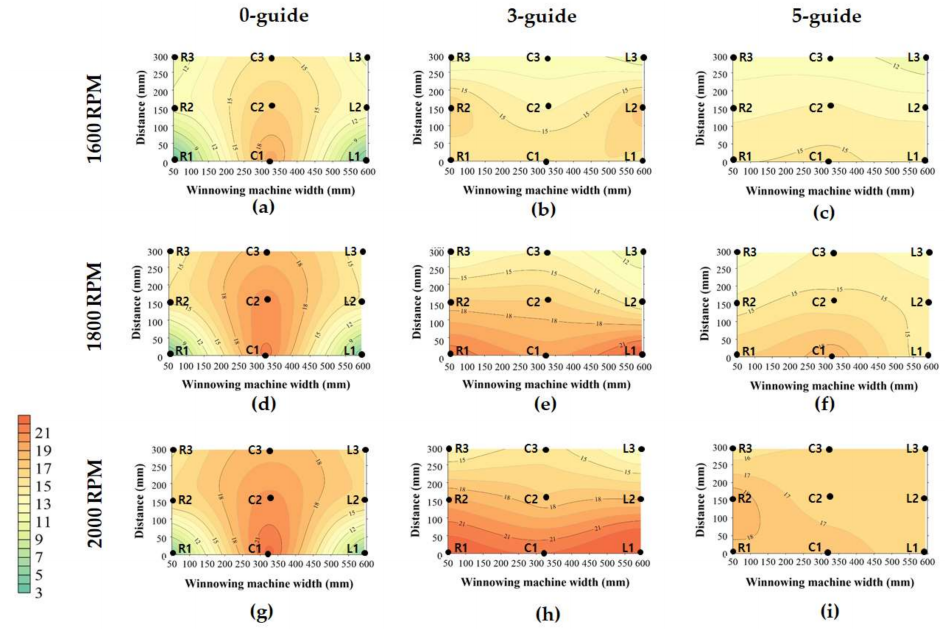
Figure 10. Results of actual measurement for wind velocity on conditions of 0-guide ( a ), 3-guide ( b ), and 5-guide ( c ) at 1600 RPM, 0-guide ( d ), 3-guide ( e ), 5-guide ( f ) at 1800 RPM, and 0-guide ( g ), 3-guide ( h ), 5-guide ( i ) at 2000